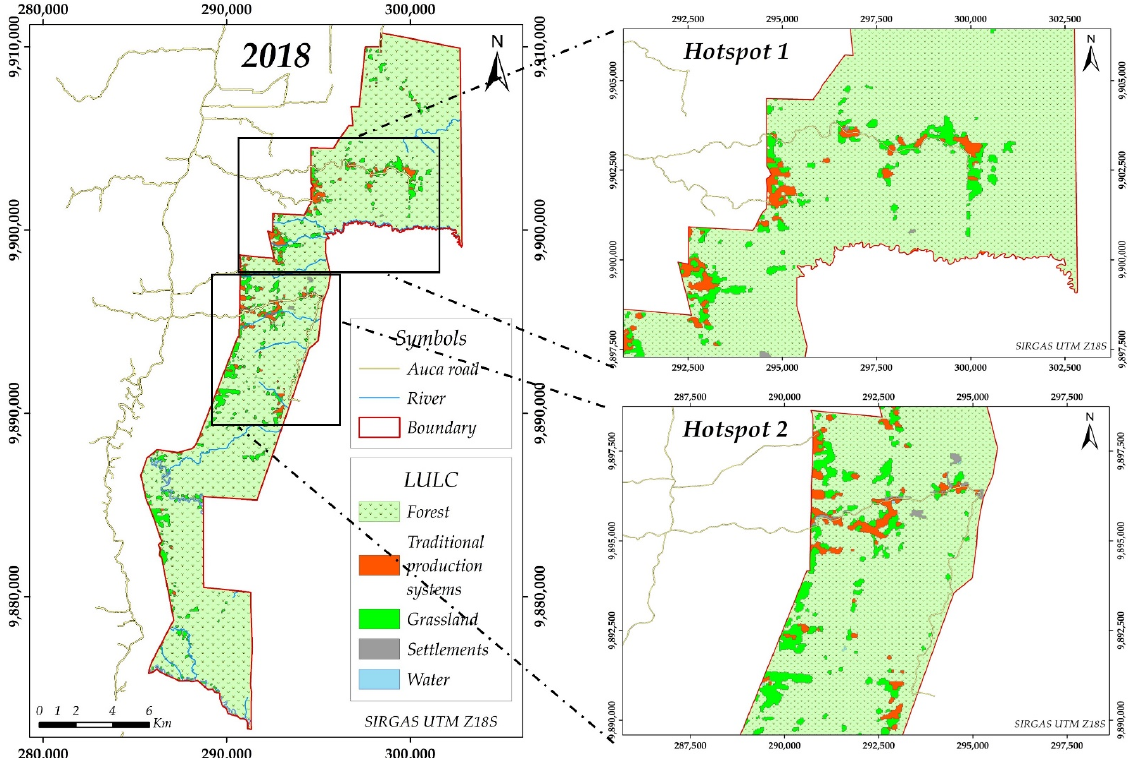
Figure 10. LULC hotspots in the DLZ’s southern zone (Inés Arango Parish) in the Yasuní Biosphere Reserve of the Ecua ‐ dorian Amazon Region.